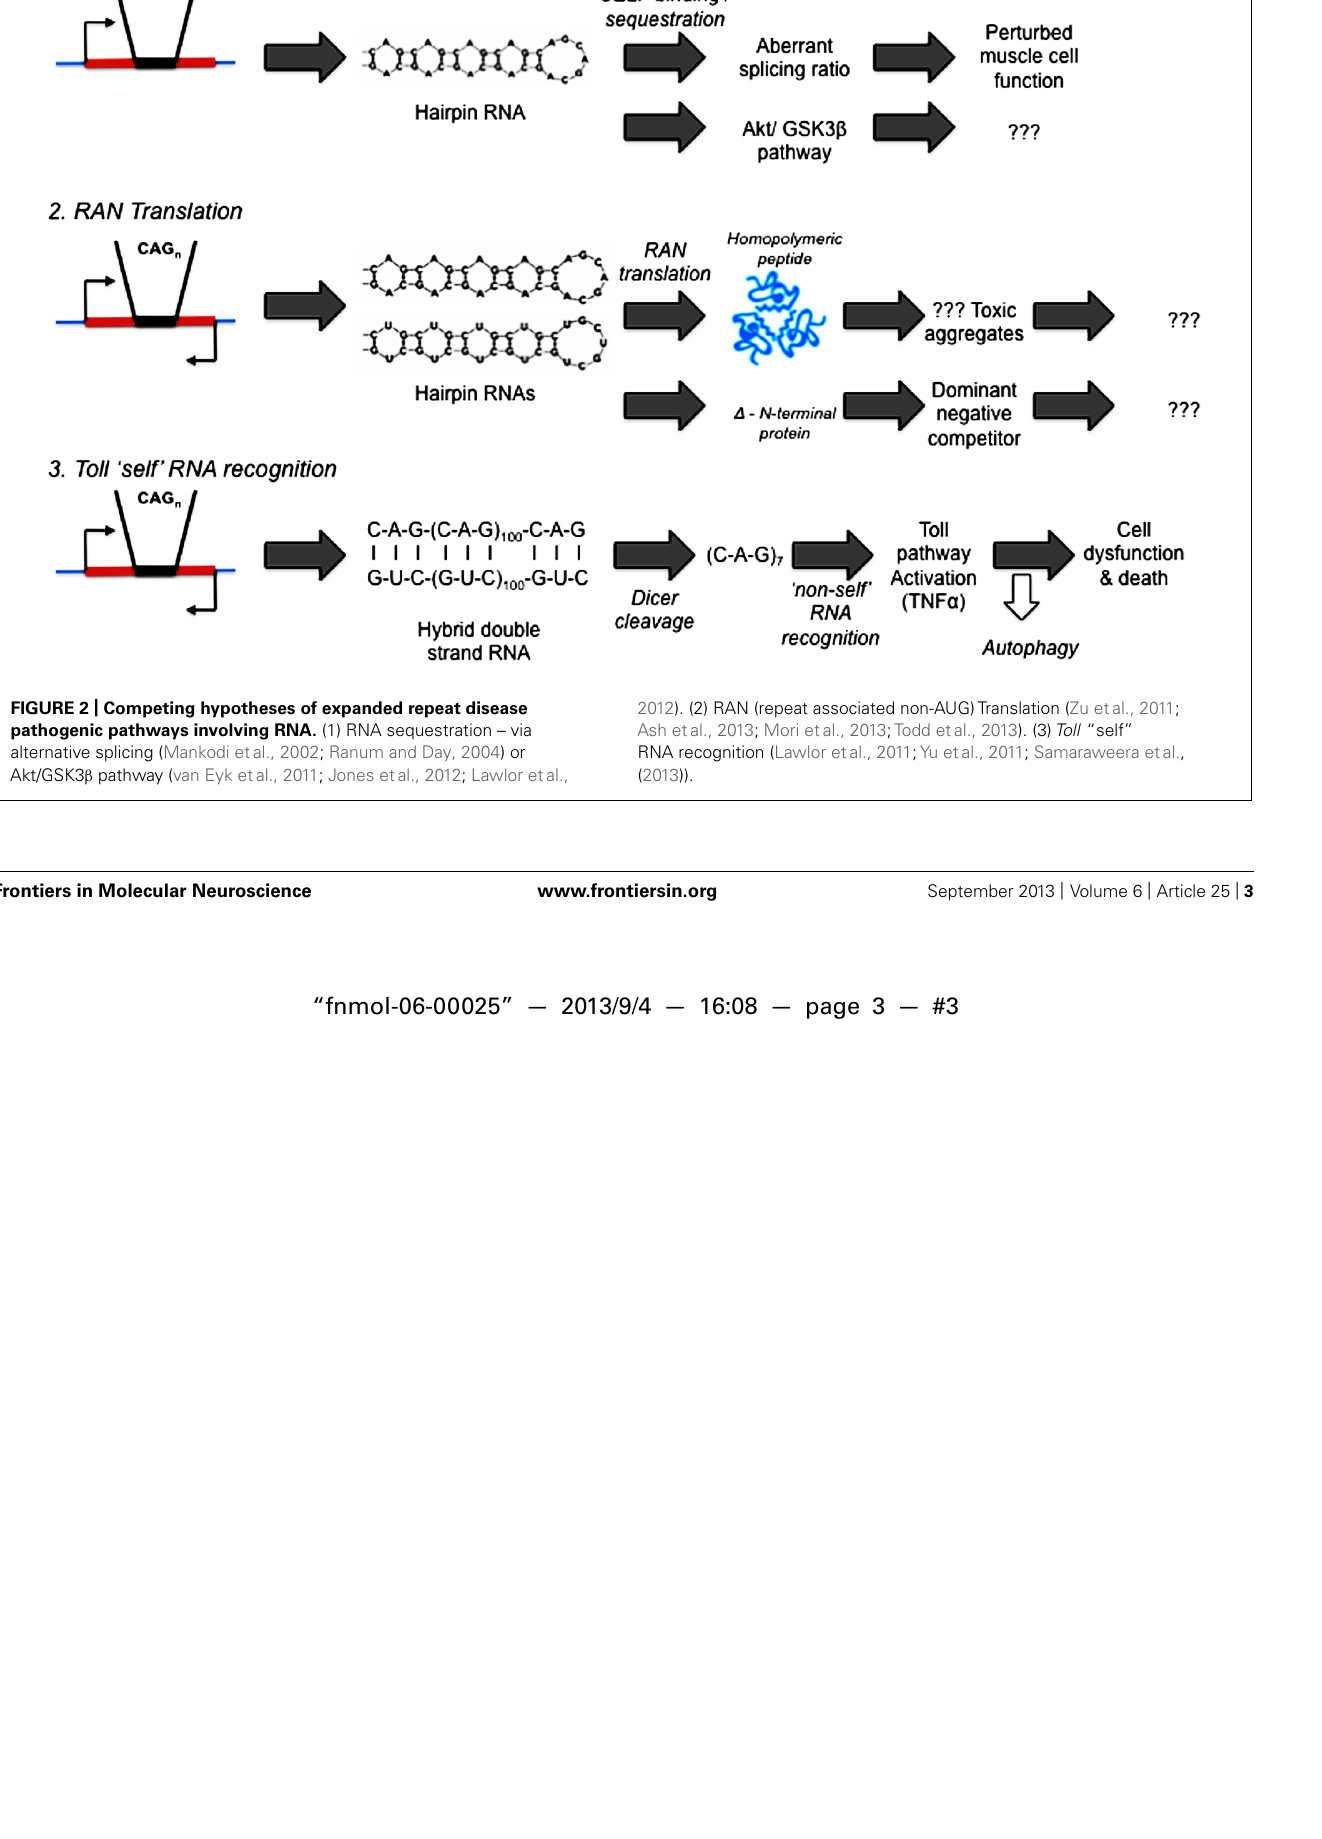
2012). (2) RAN (repeat associated non-AUG)Translation (Zu etal., 2011; Ash etal., 2013; Mori etal., 2013;Todd etal., 2013). (3) Toll “self” RNA recognition (Lawlor etal., 2011;Yu etal., 2011; Samaraweera etal.,